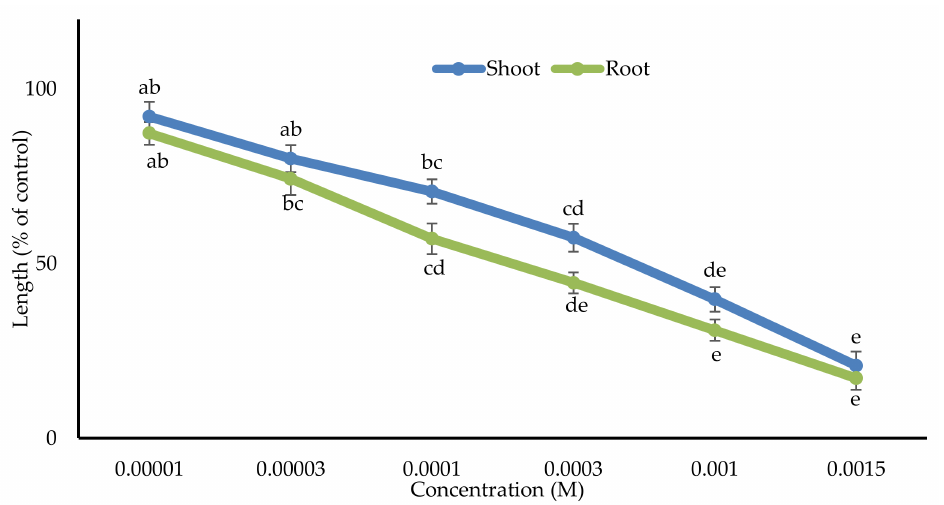
Figure 4. The phytotoxicity of compound cis -3-hydroxy- α -ionone against cress. Values indicate means ± SE from three replications ( n = 30). Significant variations between control and treatment are indicated by various letters ( p <